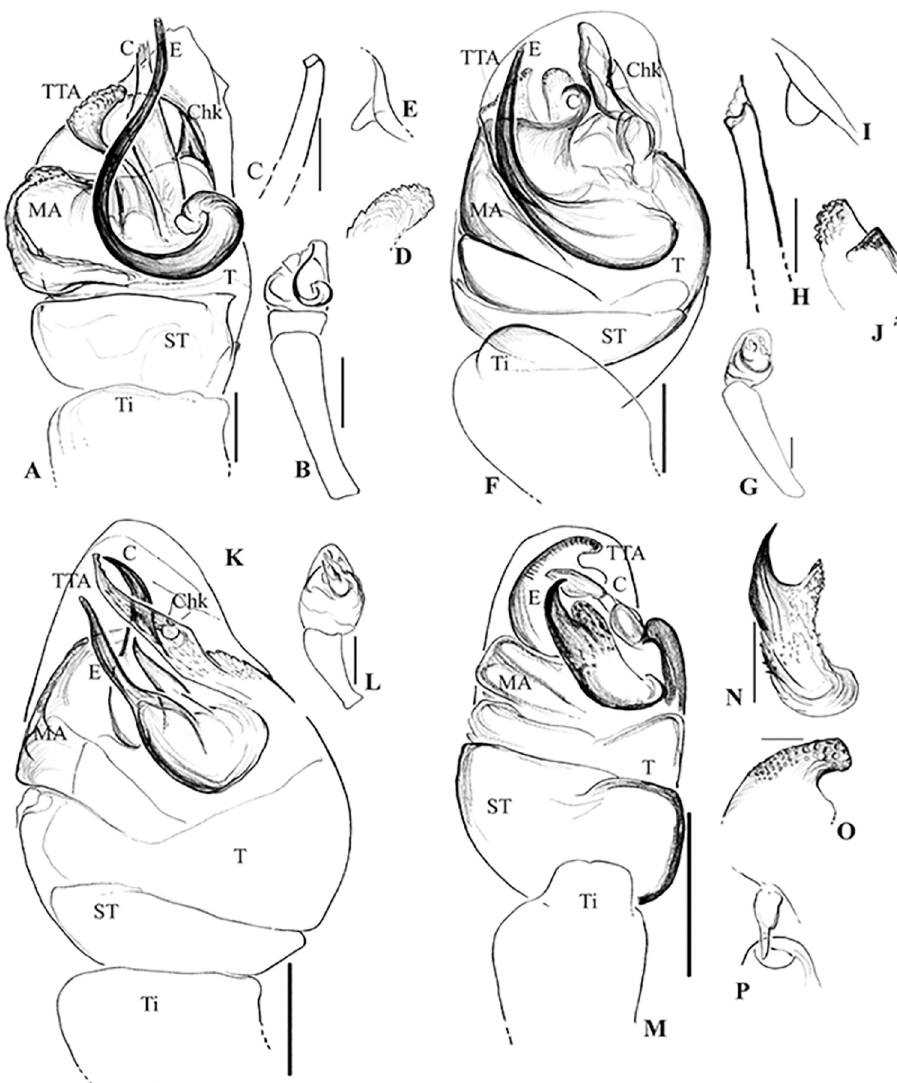
Fig 6. Male palpal morphology of Rhomphaea species in Sri Lanka. A–E, R . shanthi sp. nov.; A, left palp, ventral view; B, tibia; C, tip of embolus; D, tip of Conductor; E, cymbial hook. F–J, R . jacko sp. nov.; F, left palp, ventral view; G, tibia; H, tip of embolus; I, cymbial hook, J, tip of TTA; K–L, R . martini sp. nov.; K, left palp, ventral view; L, tibia. M–P, R . marani sp. nov.; N, embolus; O, tip of TTA; P, cymbial hook. Abbreviations = C, conductor; CD, copulatory duct; Chd, cymbial hood; Chk, cymbial hook; E, embolus; MA, median apophysis; ST, sub-tegulum; T, tegulum; Ti, tibia; TTA, theridiid tegular apophysis. Scale bars = 0.1 mm (A, F, K, M), 0.2 mm (B, G, L), 0.02 mm (C, E, H, I, J, N, O,